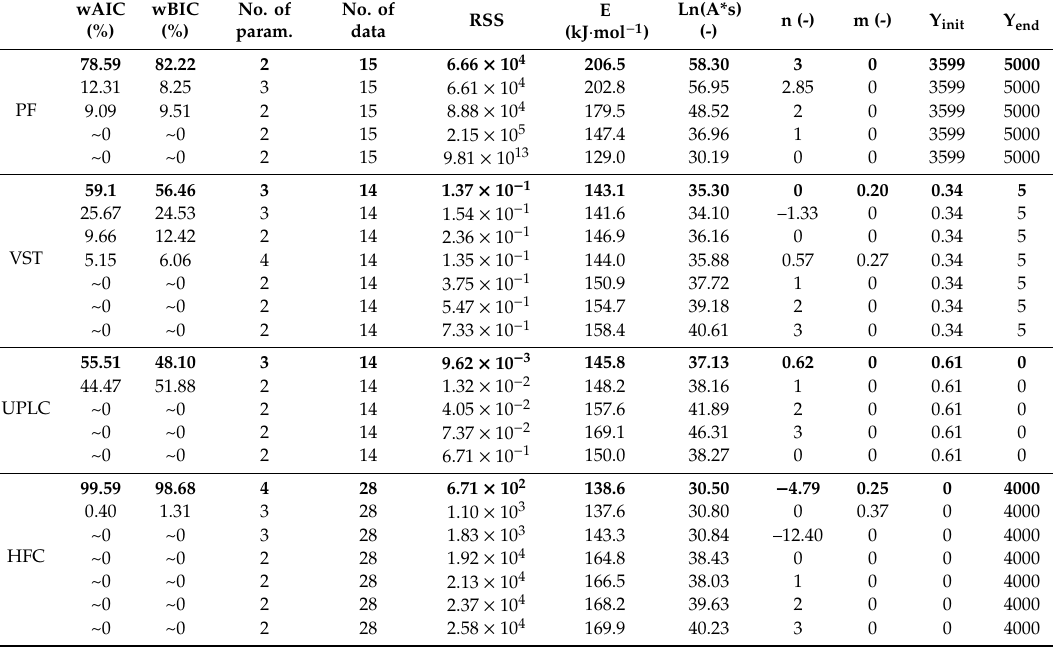
Table 1. The statistical AIC and BIC weights, sum of residual squares RSS, number of data and parameters used in simulations, initial and final values of measured quantities ( Y init and Y end ), and the evaluated kinetic parameters (activation energy, E ; pre-exponential factor, A ; reaction order exponents, n and m ) calculated for the testing methods, PF, VST, UPLC, and HFC, respectively. For each method, the statistic and kinetic parameters were calculated for the fixed integer reaction order exponents, n = 0, 1, 2, and 3, and for adjustable fitted n and m values. The results for the best models according to AIC and BIC criteria are displayed in bold. Only in one case was the reaction order model with a fixed integer n value (PF, n = 3) the best from the statistical point of view. Interpretation of the AIC and BIC criteria are explained in detail in